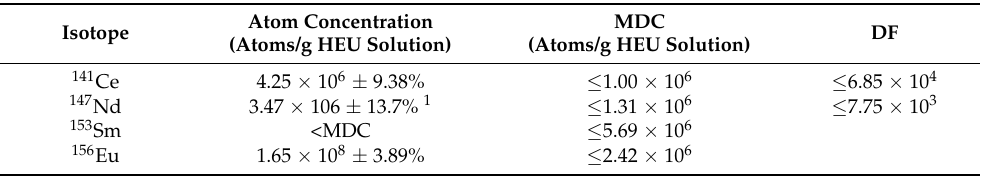
Table 5. The results from the gamma spectroscopic analysis of the separated Eu fraction; fraction 10 from each sample was counted for 17–19 h. Samples were run in quadruplicate and uncertainty on atom concentration is 1 σ .